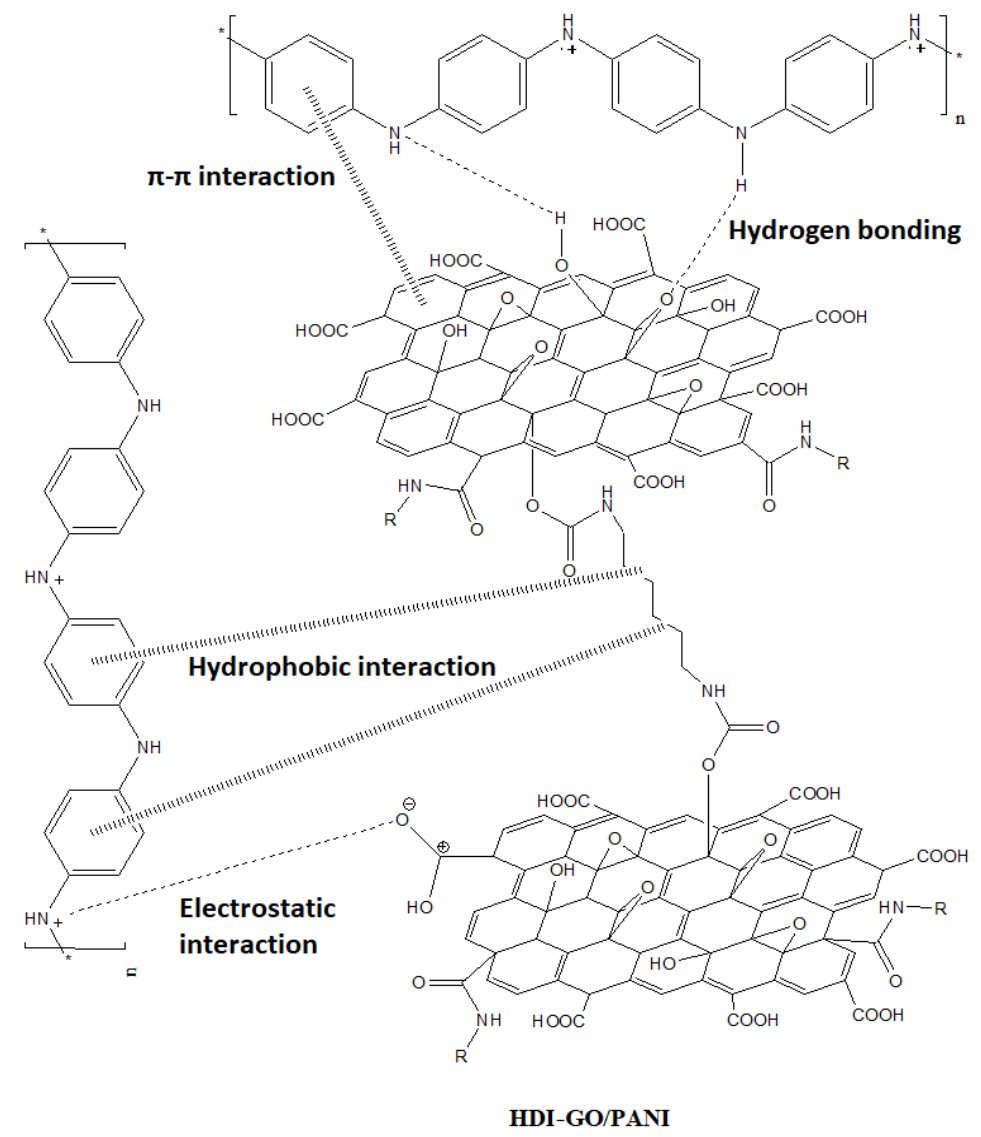
Scheme 13. Schematic representation of the different interactions between PANI and hexameth- ylene diisocyanate (HDI)-modified GO. Reprinted with permission from Ref. [71]. Copyright 2010 American Chemical